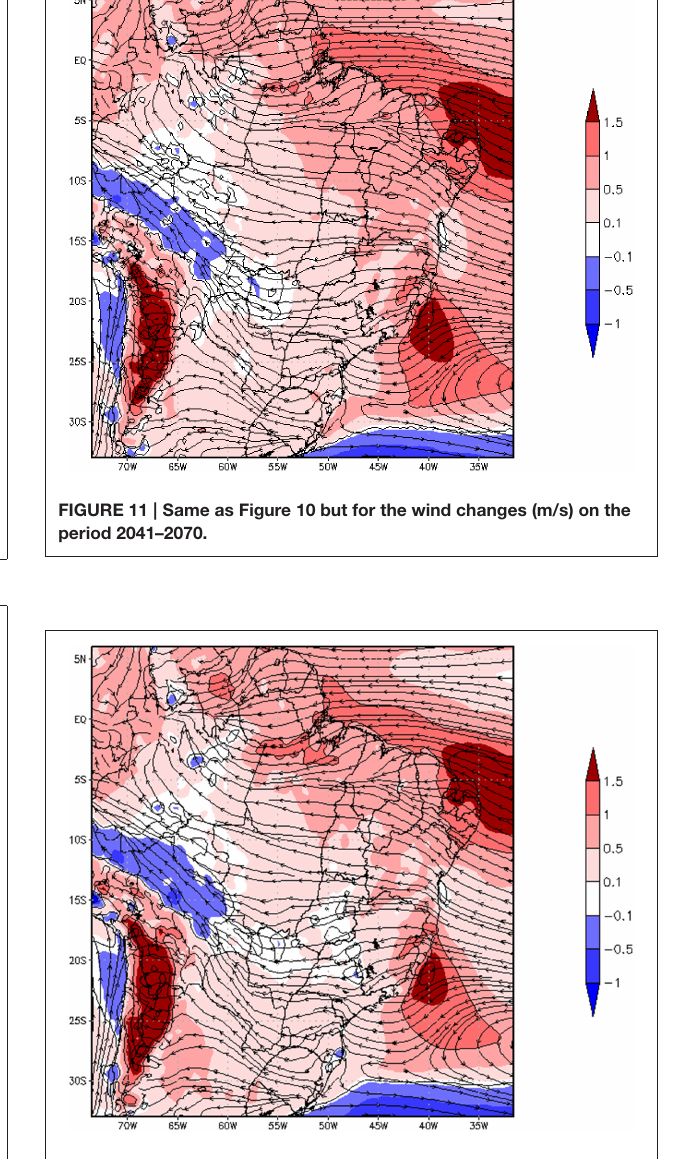
FIGURE 12 | Same as Figure 10, but for the wind changes (m/s) on the period